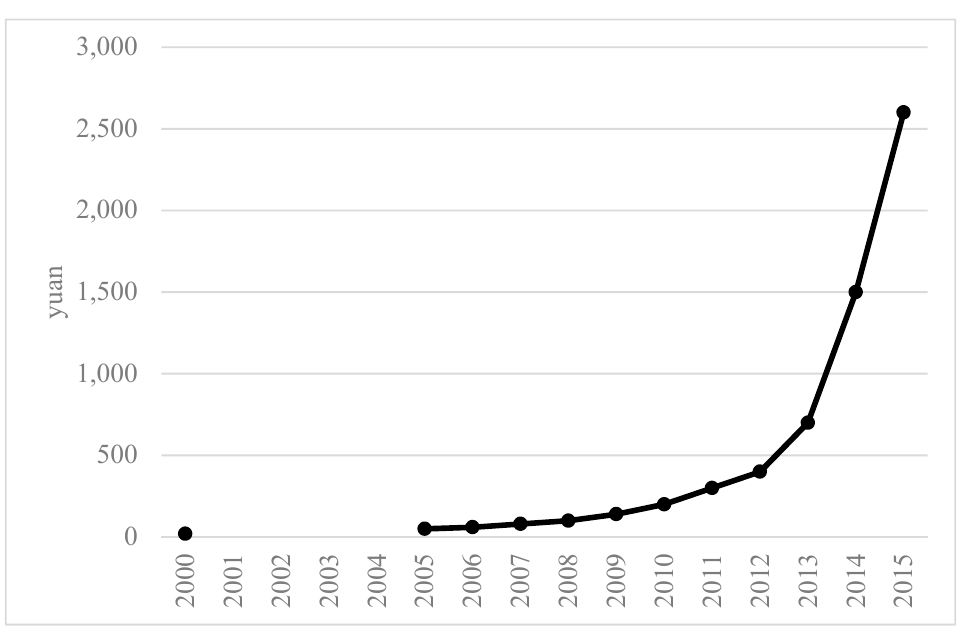
Figure 1. The price of donkey hides in China between 2000 and 2015 (in yuan). (Source: http://www.bestchinanews.com/Domestic/11652.html.).